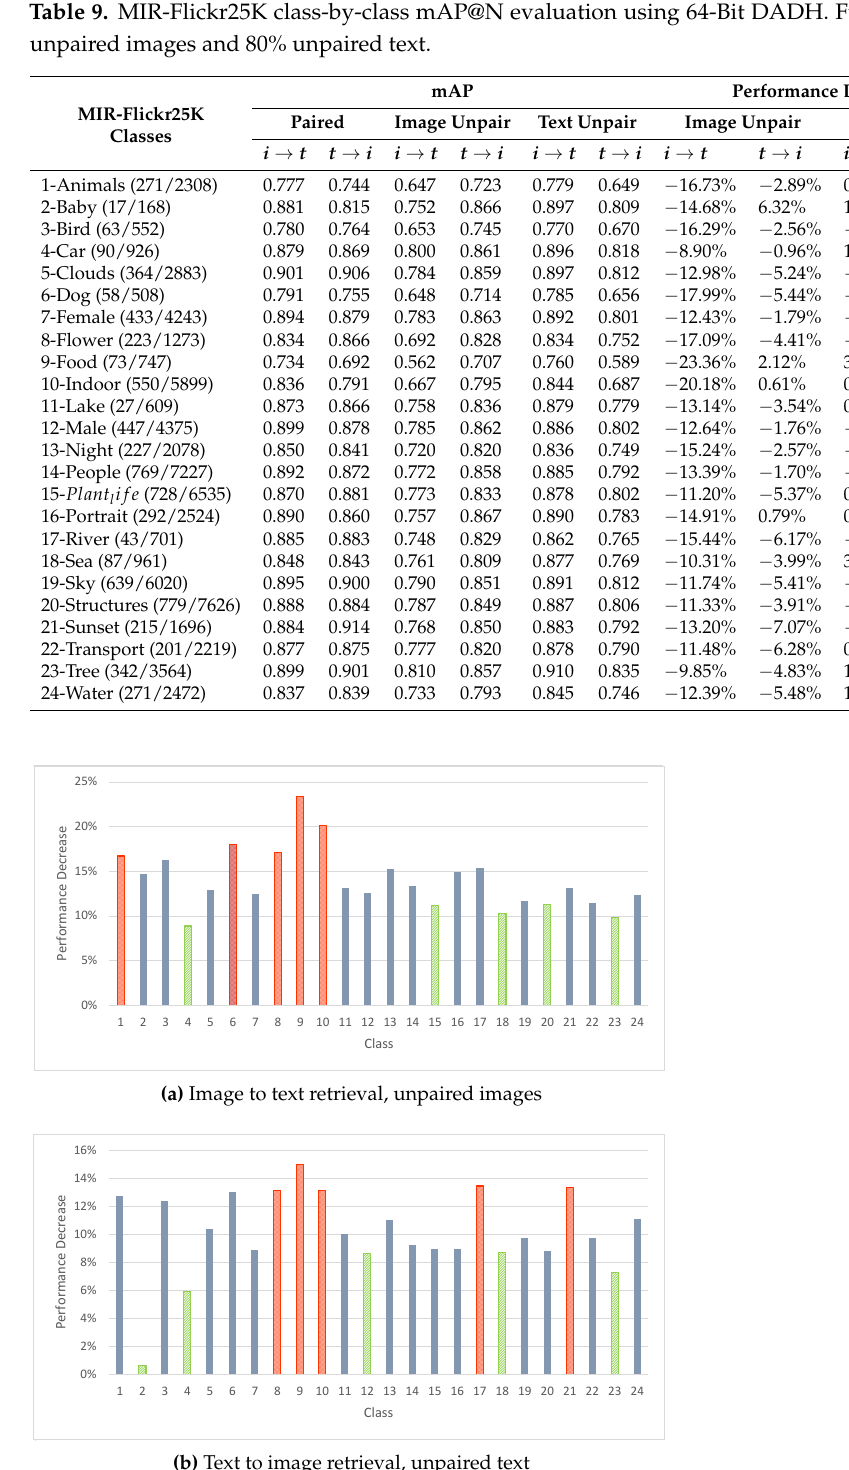
Figure 10. Percentage of performance change of DADH computed using formula (4) when training with unpaired samples compared to paired training across 24 classes of MIR-Flickr25K. Red bars show the five classes with the most performance change and green bars show the five classes with the least performance change. The remaining classes are marked as blue bars.